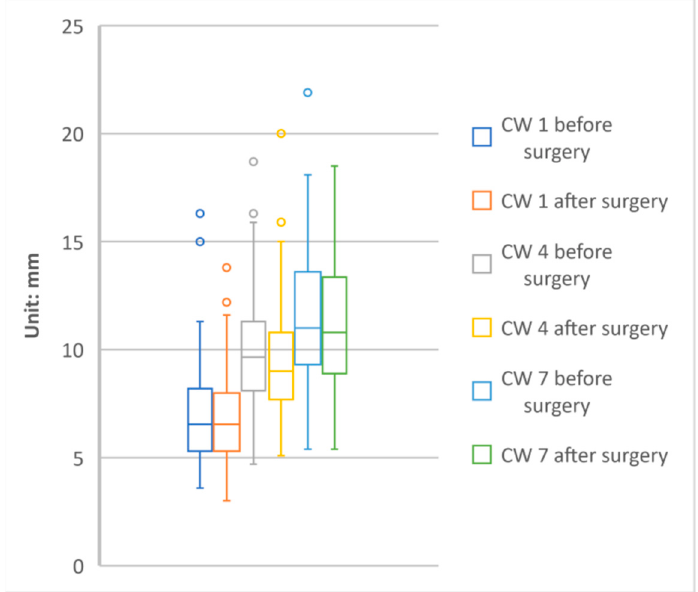
Figure 4. The distributions of alveolar bone width around the implantation site at the three levels before and after surgery; CW: sub-crestal width.